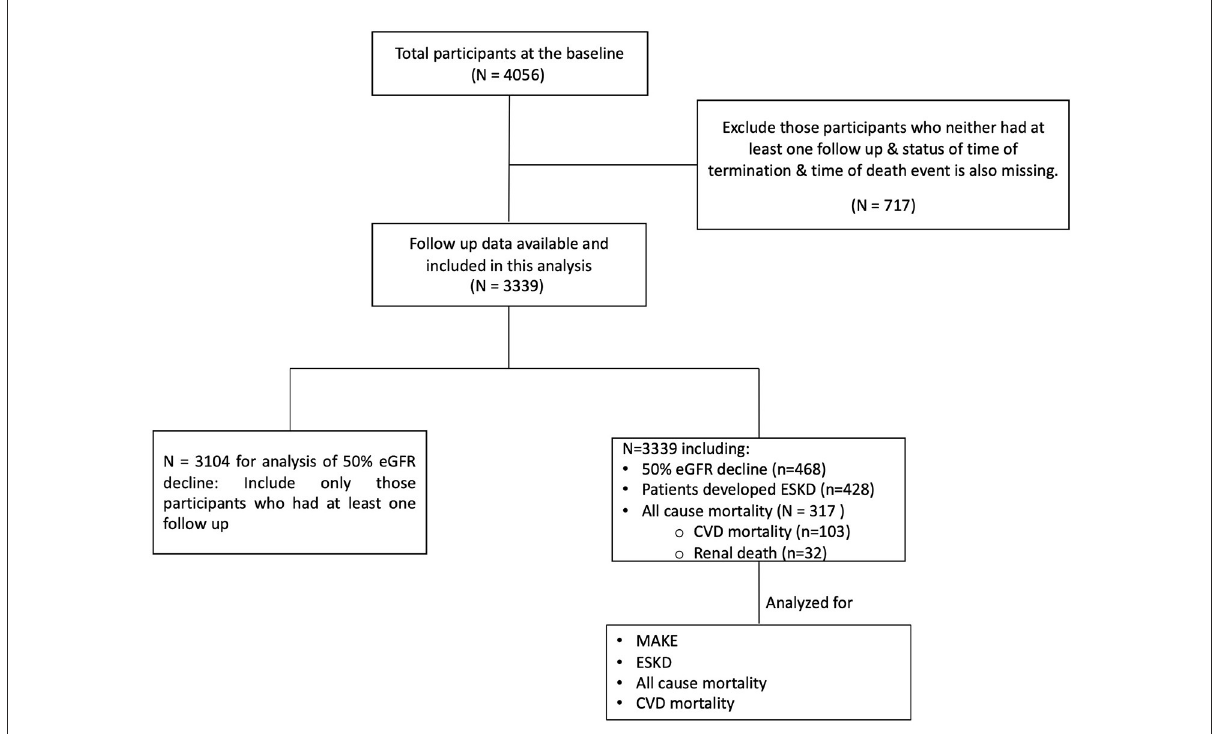
FIGURE1 Flow diagram showing study participants.